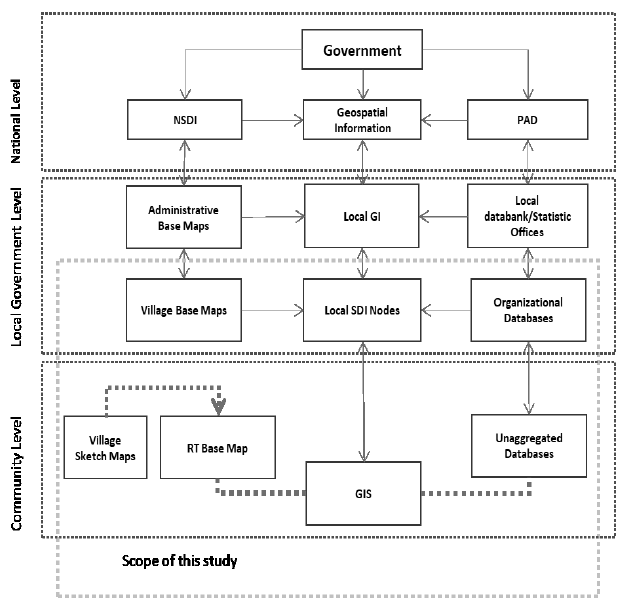
Fig. 2. framework of Linking PAD to the Neighborhood Association area and scope of this study